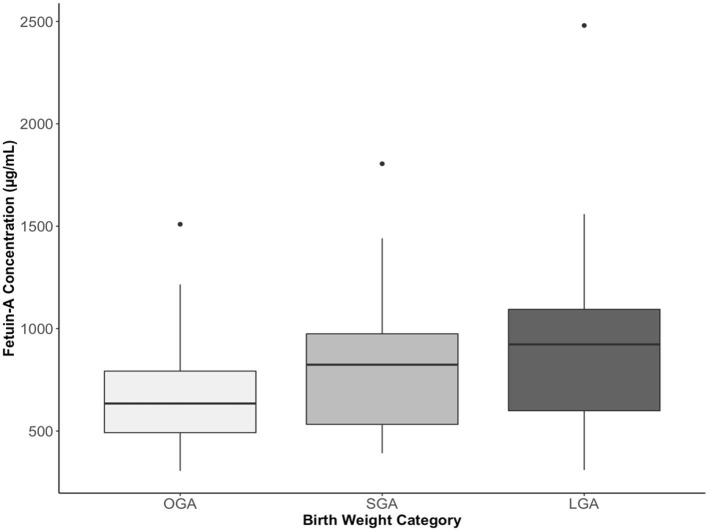
Cord plasma fetuin-A concentrations in small-, optimal-, or large-for-gestational-age (SGA, OGA, LGA) infants. The boxes represent the medians and interquartile ranges, the dots represent the maximal values. P = 0.024 comparing SGA vs. OGA, and P < 0.001 comparing LGA vs. OGA.